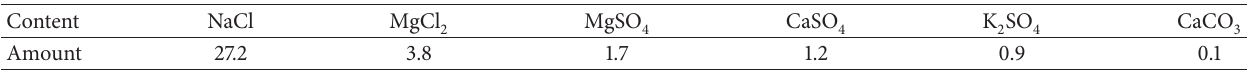
Table 3: Content of seawater (g/L).